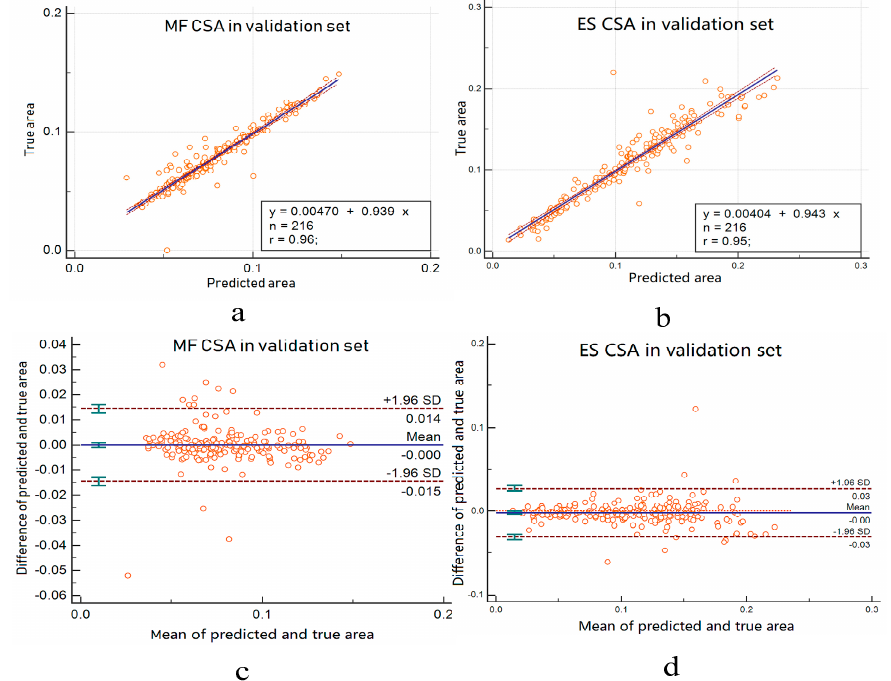
Figure 8. ( a )–( b ) Linear regression for multifidus and erector spine CSA. The blue curve is the regression curve, the orange circle is the predicted area for each image, the value of n is the number of test samples, and the value of r is R squared. ( c )–( d ) Bland–Altman analysis for multifidus and erector spinae